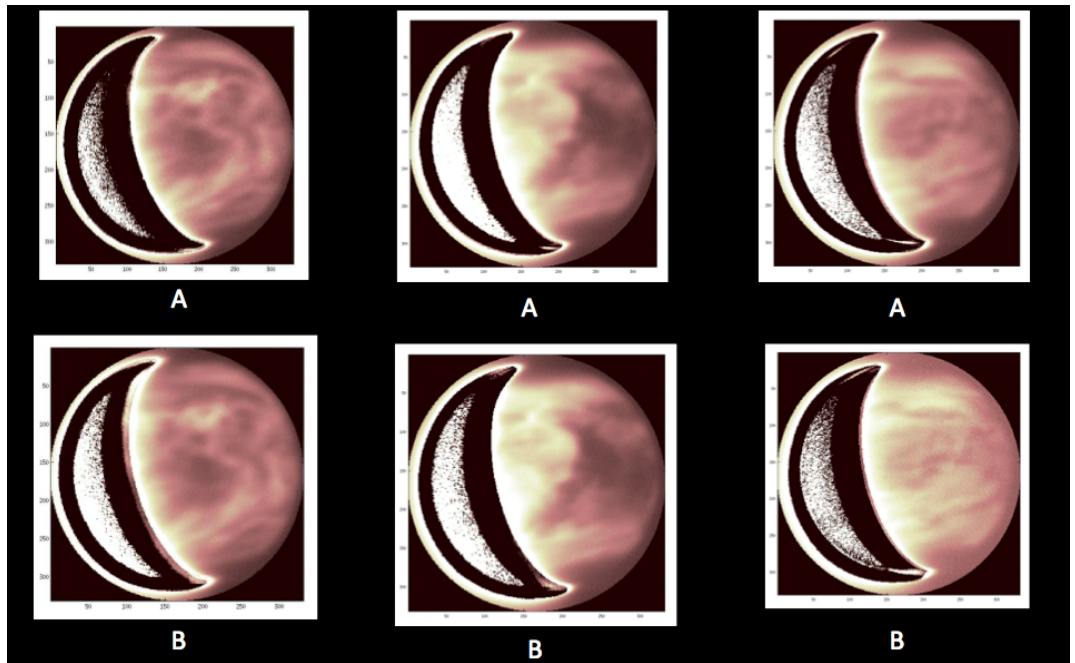
Figure 4. Images A and B are produced from a selection of the best 10% taken, which were registered to a common coordinate system and finally co-added to form the present images. The images A and B were taken with approximately one hour interval between them. In this way, we can apply the cloud tracking technique in order to retrieve the wind field at the bottom layer of Venus’ cloud deck ( ∼ 48 km). A and B images at the left were obtained in the first day of observations, the pair in the middle were taken at the second day and, finally, the A and B images on the right side of the figure were obtained at the last observing